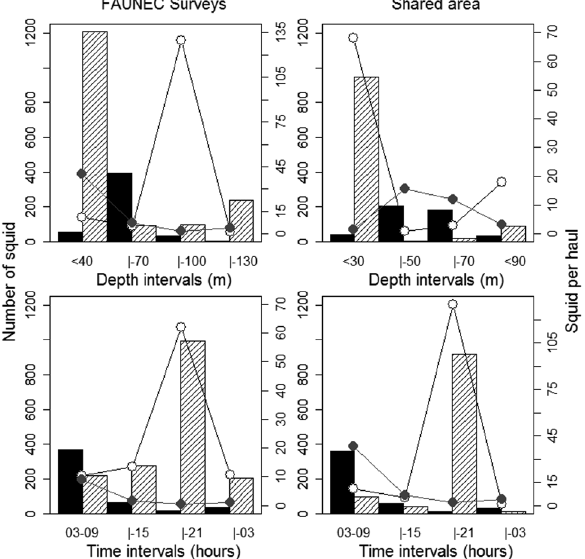
Figure 11. Total number and catch rates of Doryteuthis sanpaulensis and D. pleii collected in different depths and time of day during FAUNEC surveys and within the shared area off southern Brazil. Both metrics were calculated for stations where at least one of the two species was present (FAUNEC surveys) or where both species were present (shared area). Bars: number of squid. Circles: squid per haul. Crosshatched bars and empty circles: D. sanpaulensis . Black bars and dark grey circles: D. pleii .